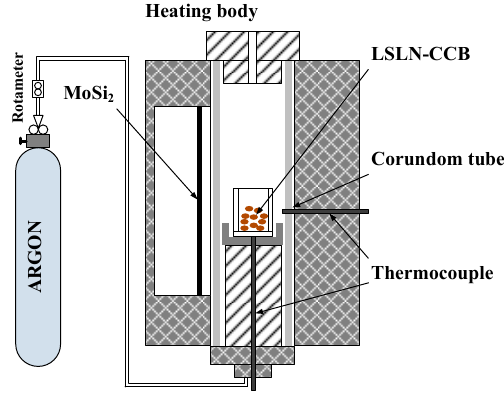
Figure 2. Process diagram of metallized reduction–magnetic separation.